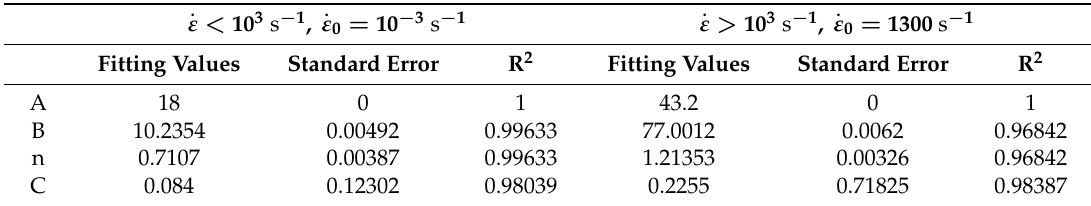
Table 3. Fitting parameters of the JC model.